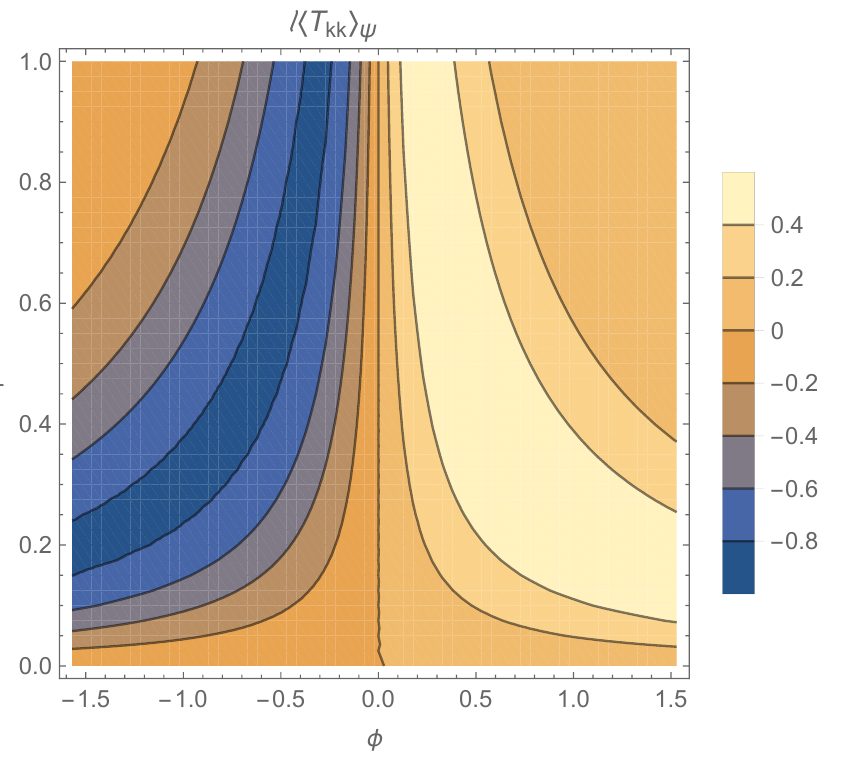
Figure 4 . Plot of ‘ h T kk i at extremality for a spinor at various values of r + = r (cid:0) and (cid:30) . The p four dimensional mass m = 1 and ‘=R = 10. The cuto(cid:11) (cid:15) = 0 : 1, the sum over Kaluza-Klein S 1 modes was performed to N = 20, and the sum over BTZ images was performed to n =